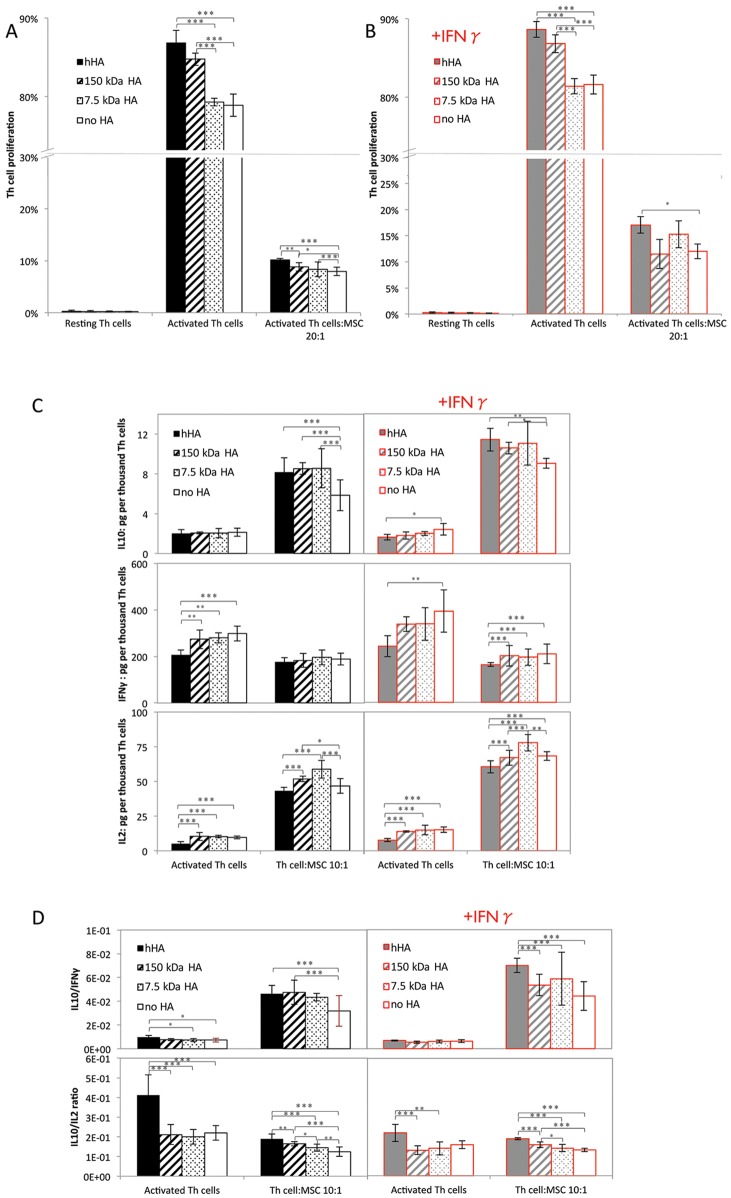
Effect of different MWs of HA on the interaction of MSCs and Th cells.Proliferation of Th cells, in the presence or absence of MSCs, without (A), and with IFNγ supplementation (B). (C) IL10, IFNγ and IL2 secreted levels in medium from activated Th cells with or without MSCs, and with or without IFNγ supplementation. (D) Ratios of secreted IL10/IFNγ, IL10/IL2. Solid filled bars stand for hHA; hatched bars, 150 kDa HA; dotted bars, 7.5 kDa HA and empty bars, no HA. Black color, normal conditions and gray color with red frame, IFNγ-supplemented conditions. All data shown is from one representative MSC donor; additional data from three other donors shown in S7 Fig. Statistical differences in the presence of MSCs account for MSCs from 4 donors, each tested in triplicate. Statistical differences in the absence of MSCs account for Th cells from one donor tested in quadruplicate. Error bars represent 95% CI. * p<0.05, ** p<0.01 and ***<0.001.